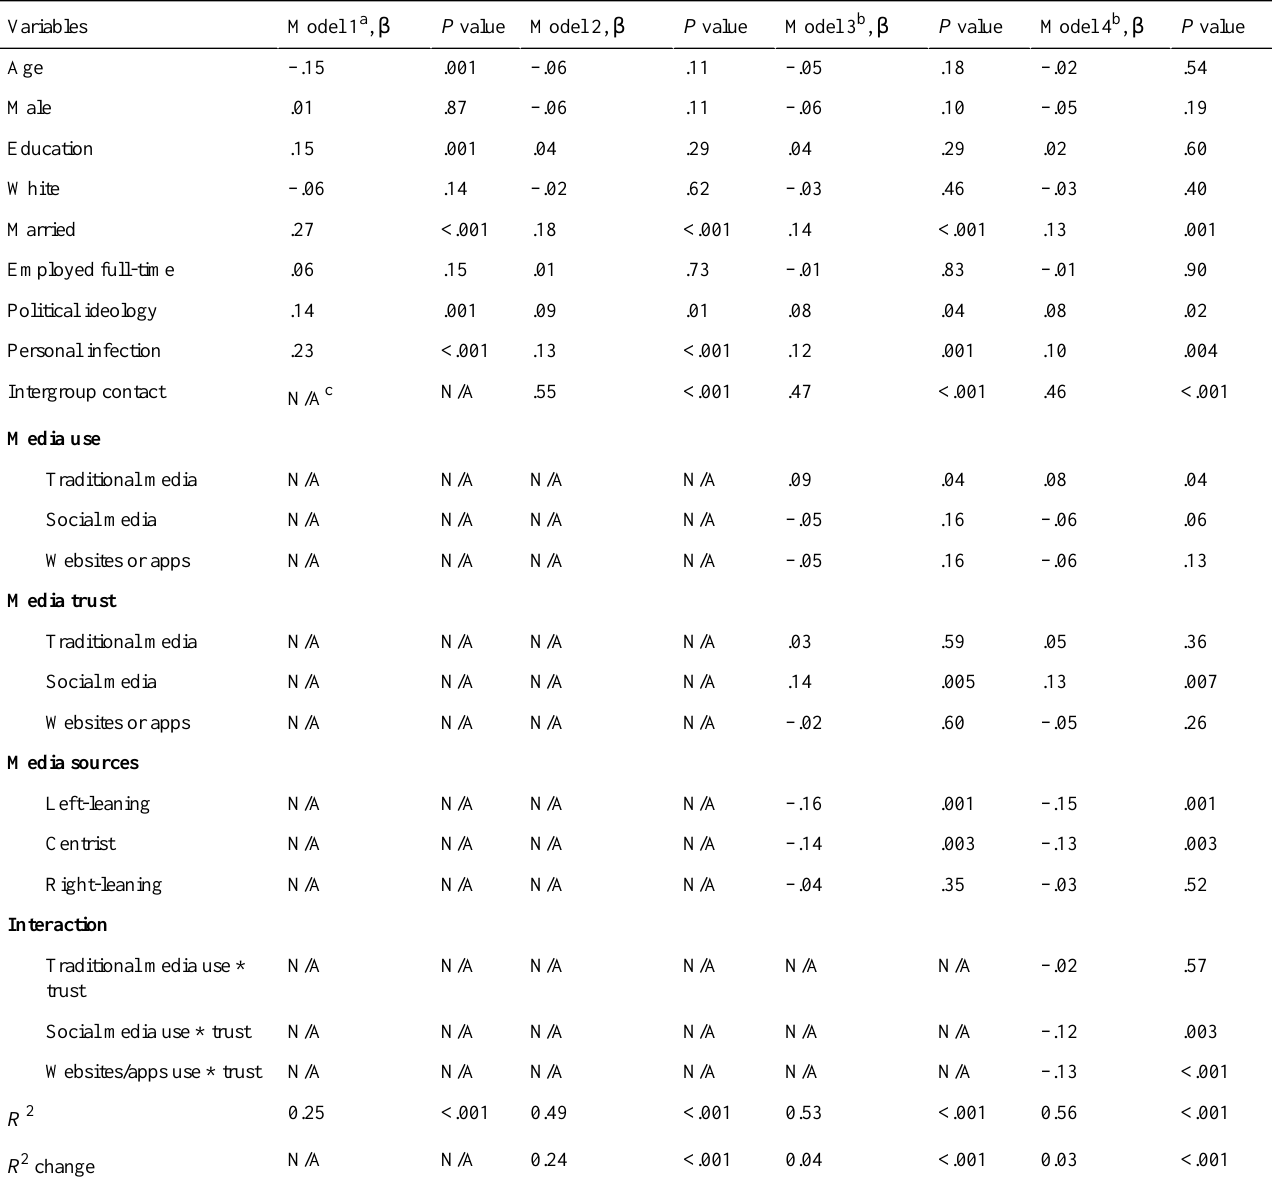
Table 3. Hierarchical regression analysis predicting prejudicial attitudes toward Asians since COVID-19